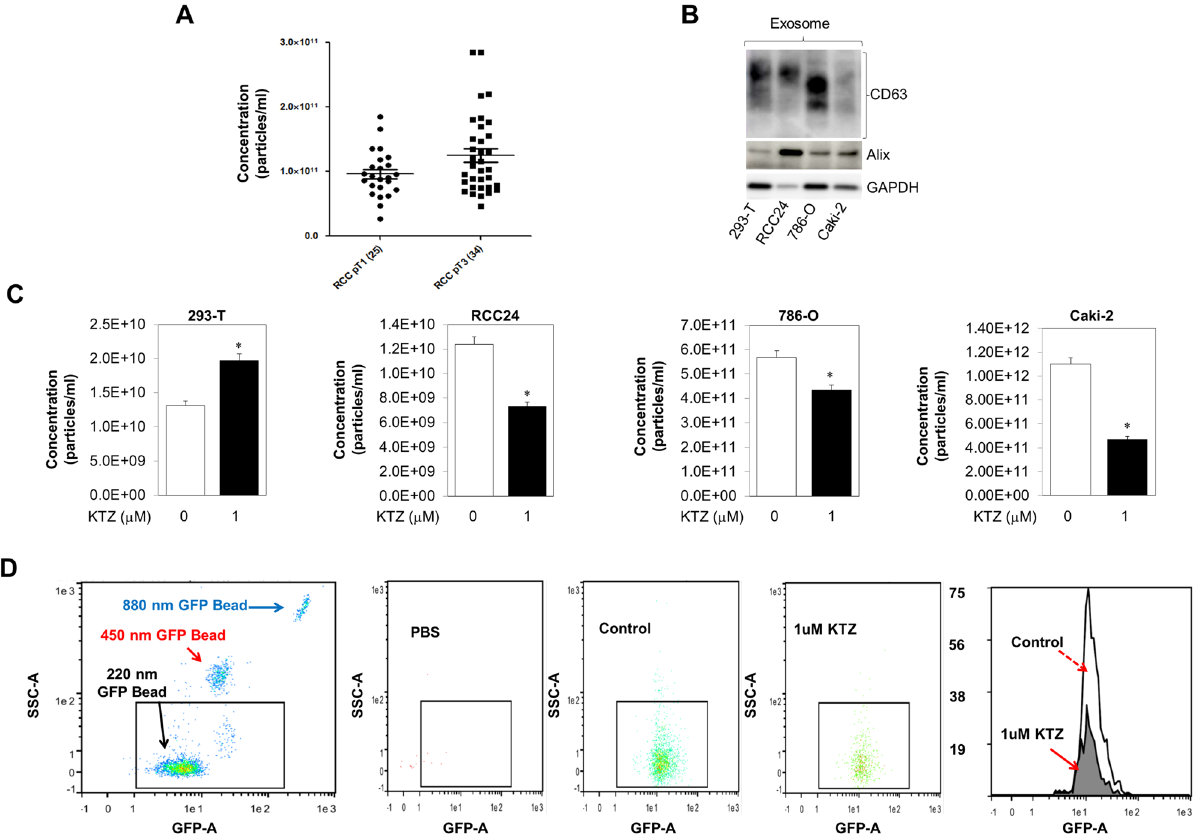
Figure 1. Measurement of exosome secretion by qNano analysis. ( A ) Total number of EVs in the plasma of patients with Kidney cancer and matched controls were measured by a qNano analysis ( n = 59). ( B ) Expression of exosome CD63, and exosome biogenesis markers Alix in the exosome of 293-T, RCC-24, 786-O, and Caki-2 cells. Exosomes were isolated by UC and filtration (0.45 μm). Full blots are presented in Supplementary Fig. S6 ( C ) qNano-IZON particle quantitative analysis (NP-100 nanopore) depicting a significant decrease in exosome concentrations (50–200 nm size) in the CM of RCC-24, 786-O, and Caki-2 cells treated with KTZ compared to vehicle treated controls, but not normal kidney HEK 293-T cells. *Denotes significance at p < 0.05 compared to controls and was calculated using GraphPad Prism. ( D ) Inhibition of exosome secretion using the MACSQuant Analyzer 10 Flow Cytometer and qNano-IZON: The exosome in the conditioned media were isolated and analyzed by the MACSQuant Analyzer 10 Flow Cytometer as described in the “Materials and methods” section. Treatments were at concentrations of 1 μM ketoconazole compounds. Exosome from DMSO treated 786-O-CD63-GFP is used as GFP control and PBS served as a reference control. *Denotes significance at p < 0.05 compared to controls and was calculated using GraphPad Prism. Data for EVs and exosomes was captured using IZON’s Control Suite software version 3.4.2.48. This software can be found at https:// suppo